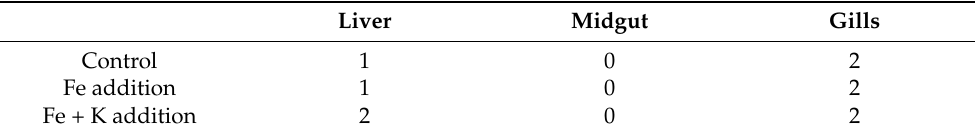
Table 4. Severity score (0–4) for the observed histopathological alterations in fish liver, midgut, and gills.